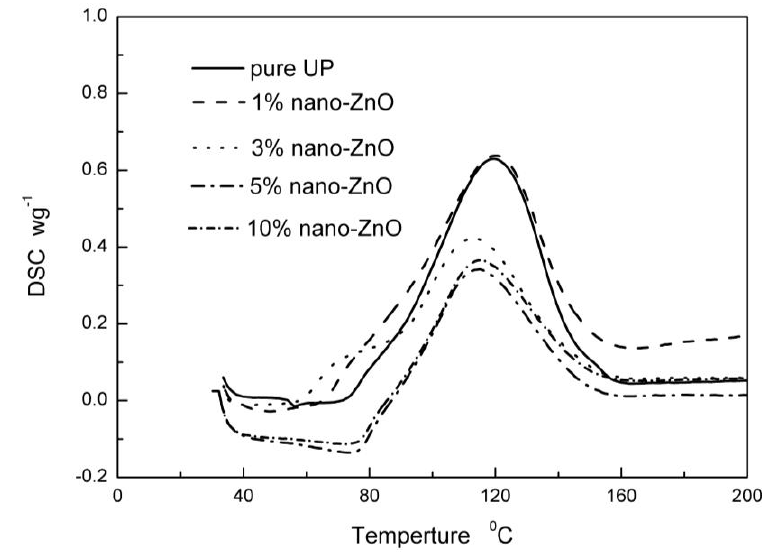
Figure 6. DSC analysis diagrams of the curing reaction process of ZnO/UP nanocomposites.